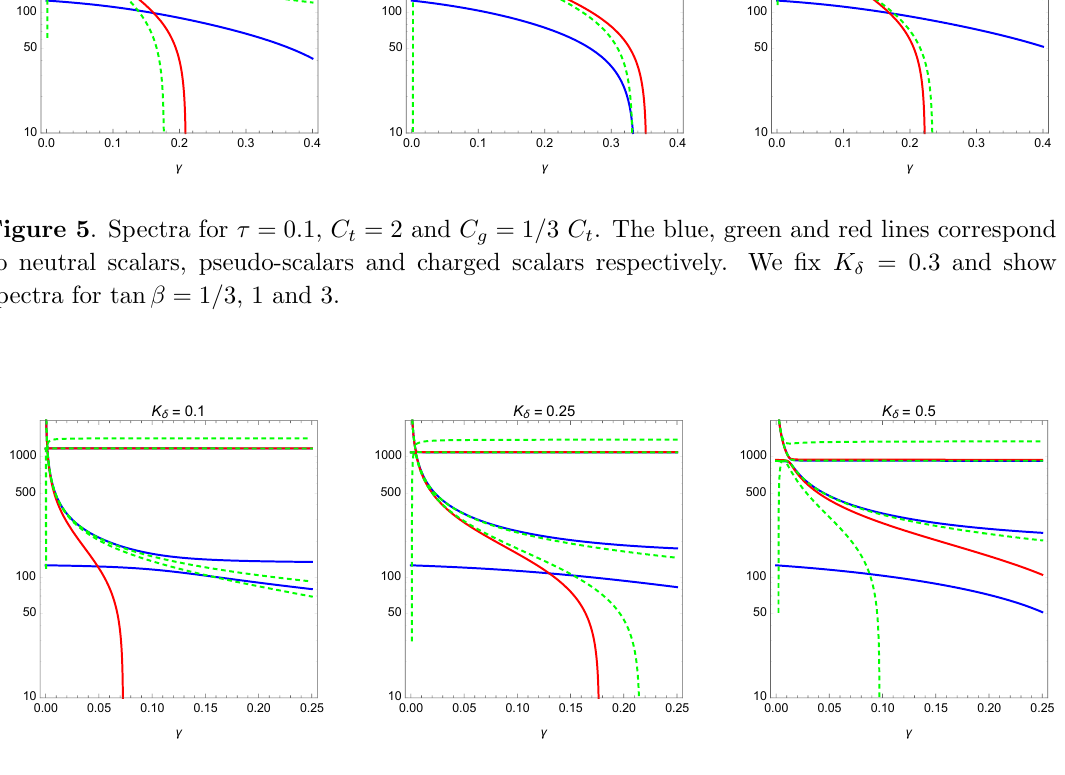
Figure 6 . Same as (cid:12)gure 5 for (cid:12)xed tan (cid:12) = 1 = 3, showing spectra for K (cid:14) = 0 : 1, 0 : 25 and 0 :